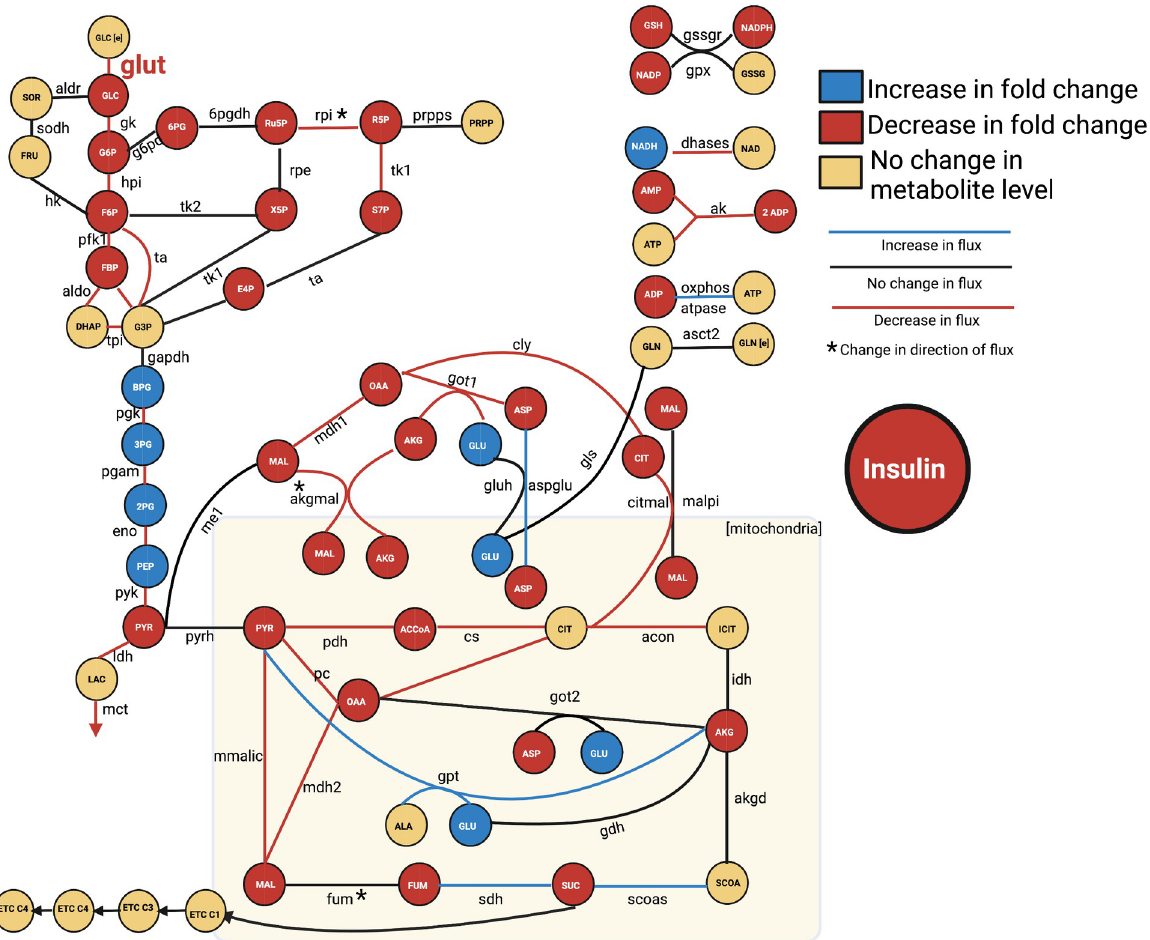
Fig 8. Effect of metformin treatment. We implemented metformin as an 80% knockdown of the glucose transport ( glut2 ) reaction and assessed the effect on the network, comparing metabolite levels, reaction fluxes, and insulin secretion to the unperturbed condition.